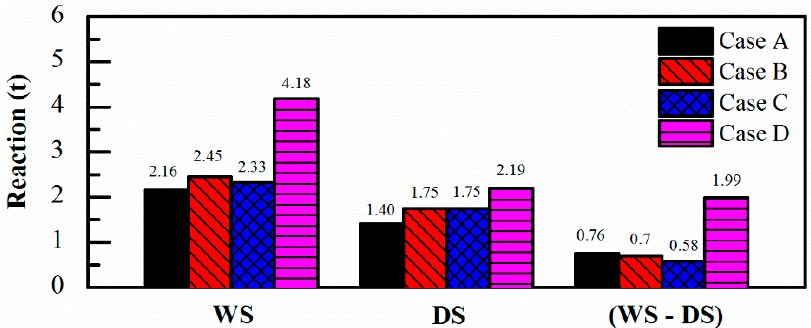
Figure 12. Average reactions at WS and DS and reaction difference between WS and DS.